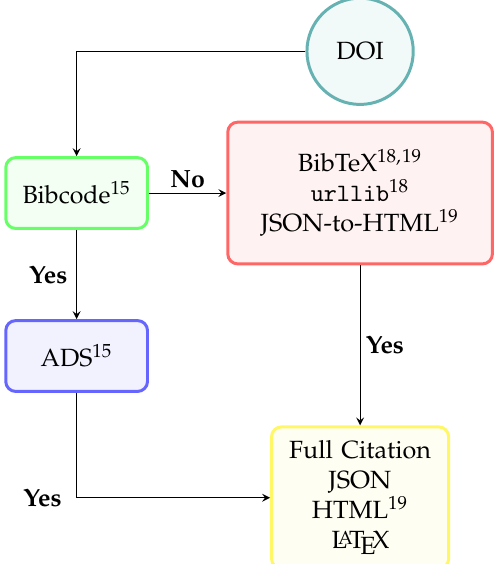
Figure 6. A diagram of the steps required to retrieve a reference from an article in multiple formats. The superscripts above the method names and outputs refer to the references for those